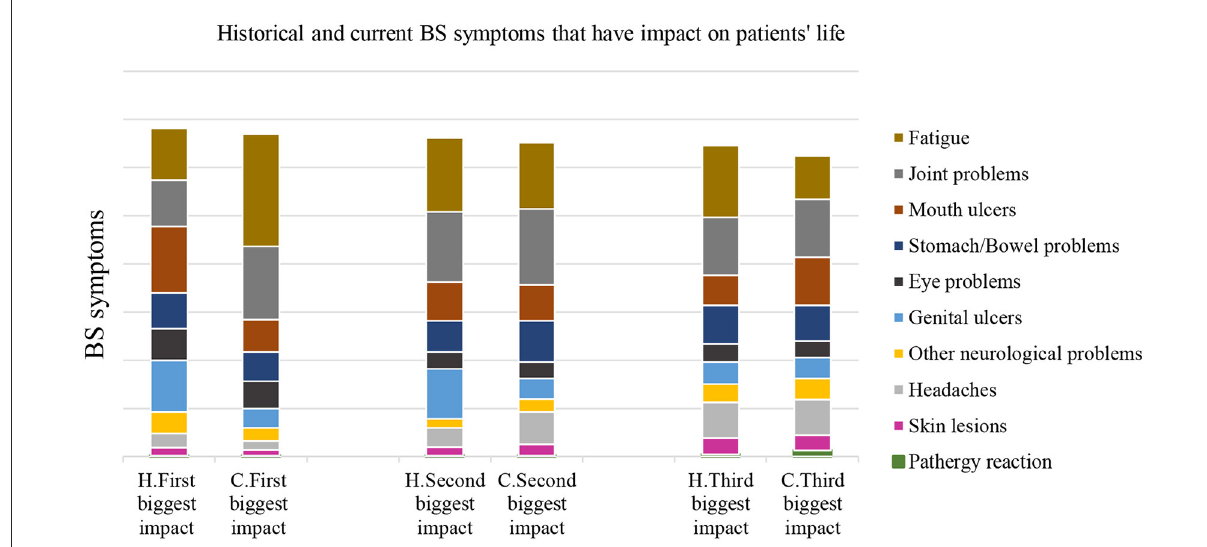
FIGURE1 BS patients and their answer about the most historical (H) and current (C) symptoms that have impact on their life of 2020 survey. The historical symptom that had a negative impact on patients HRQoL, were ranked as follows; mouth ulcers that had a high impact on their QoL. The 2 nd and 3 rd ranking was mainly fatigue and joints problems, respectively. However, the current symptoms that had negative impact on their HRQoL; 1 st , 2 nd , and 3 rd were fatigue, joint problems, and then oral